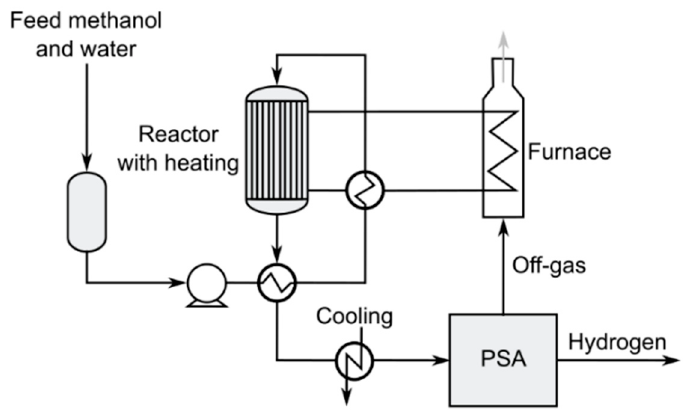
Figure 3. Conventional layout of a methanol steam reforming process [37].